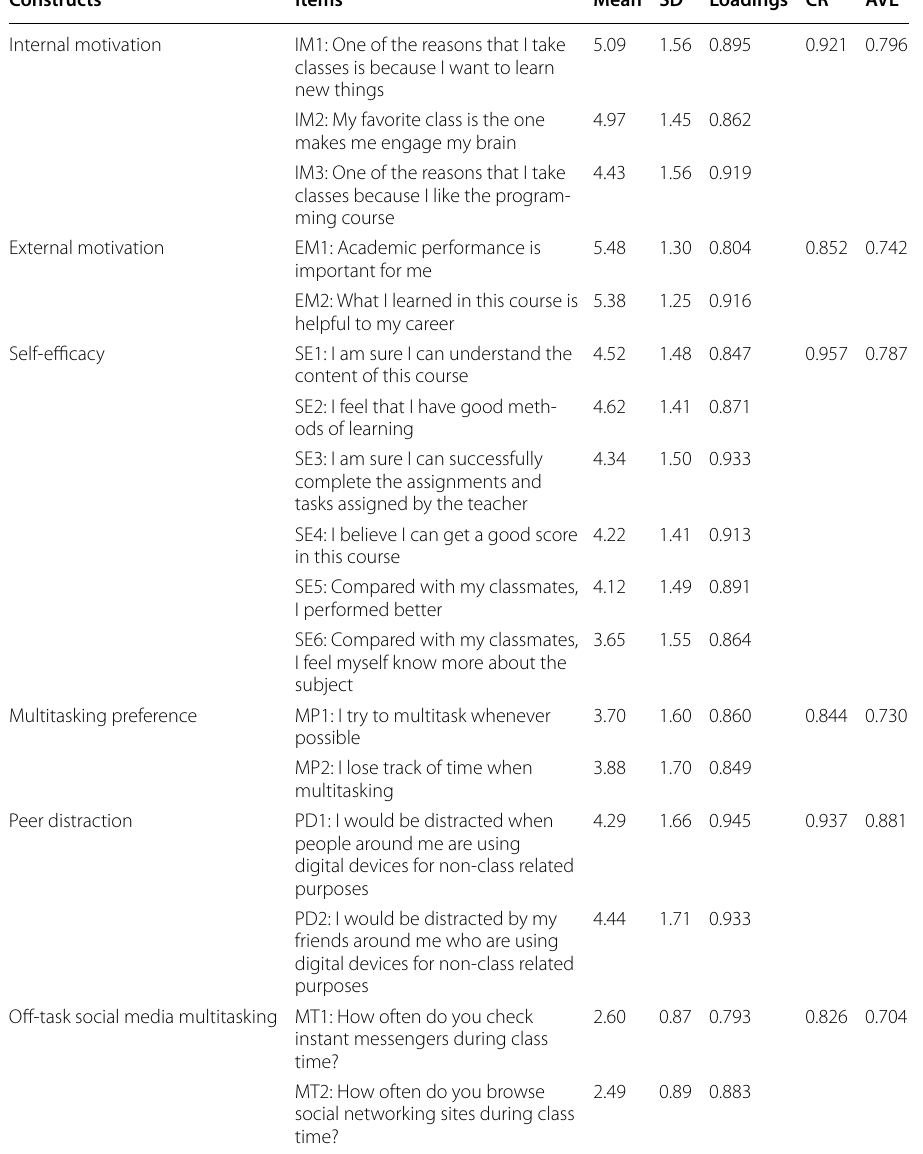
Table 2 Measurement